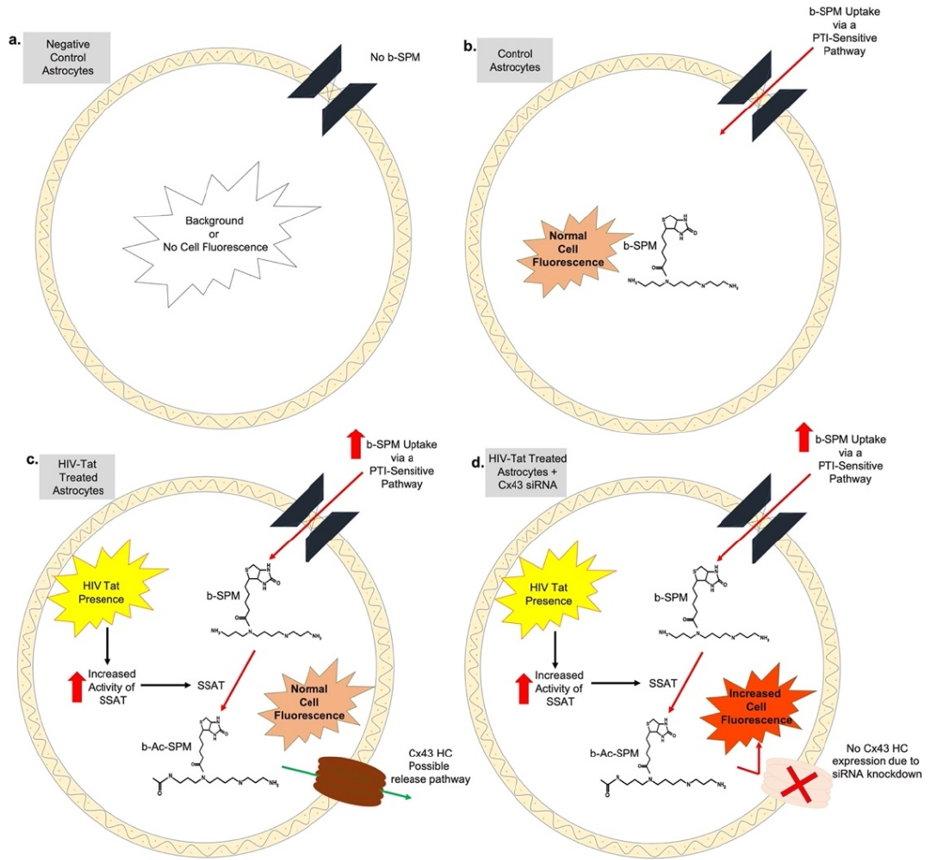
Figure 6. Summary model. ( a ) Negative control astrocytes were not exposed to b-SPM molecule (no b-SPM). The signal obtained from this group of negative control cells was considered to be the background or no cell fluorescence. ( b ) In control astrocytes, b-SPM is taken up by a PTI-sensitive uptake mechanism. ( c ) In HIV-Tat-treated astrocytes, there is increased activity of SSAT [27]. This leads to increased b-SPM uptake within the cell; b-SPM may be converted to Ac-SPM (perhaps b-Ac- SPM) and released. The overall levels of PAs within the cells are stable, suggesting that additional b-SPM is taken up into the cell to maintain a stable pool. ( d ) In the situation where astrocytes are treated with HIV-Tat and the Cx43 HCs are also knocked down using siRNA, the b-SPM accumulation as measured by increased cell fluorescence is more notable, suggesting that Cx43 HC are a release pathway for Pas, particularly in HIV-Tat-treated astrocytes. This increase in cell fluorescence may be due to the presence of b-SPM and/or “b-Ac-SPM” (via conversion of b-SPM to b-Ac-SPM due to SSAT being highly activated in HIV-Tat-treated astrocytes) and their inability to be released due to knockdown of Cx43 HC